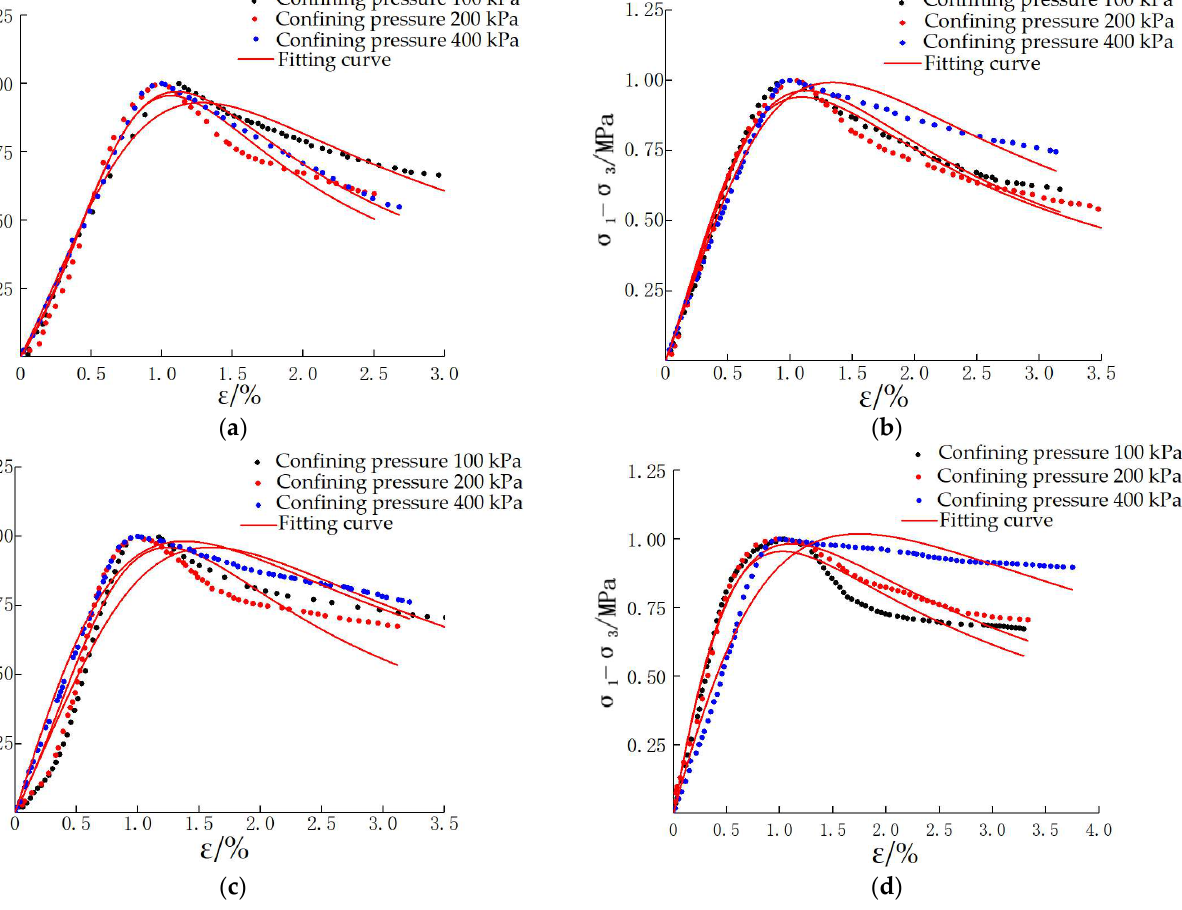
Figure 9. The measured value and curve fitting diagram of fiber cement soil under confining pressure. ( a ) fiber content 0%; ( b ) fiber content 0.1%; ( c ) fiber content 0.2%; ( d ) fiber content 0.4%.